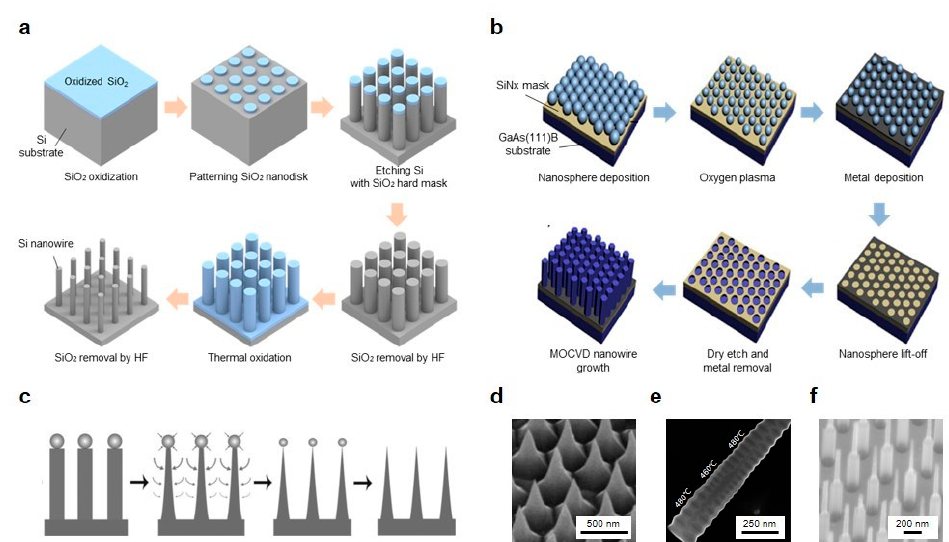
Figure 3. ( a ) Top-down approach of Si nanowire array fabrication. ( b ) Bottom-up approach of GaAs nanowire array fabrication. ( c ) Tapering process by controlling the etching rate. ( d ) SEM image of tapered nanowire arrays after the additional etching steps. ( e ) SEM image of a single nanowire with